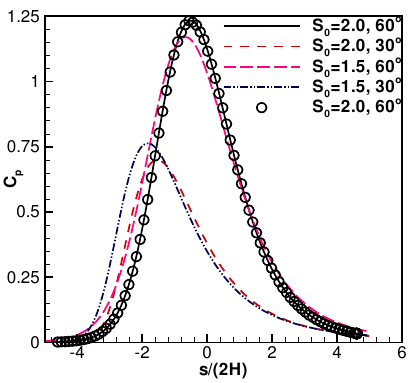
Figure 8. Specular planar plate, surface C p , s ( s ) . Lines: analytical; symbols: DSMC.